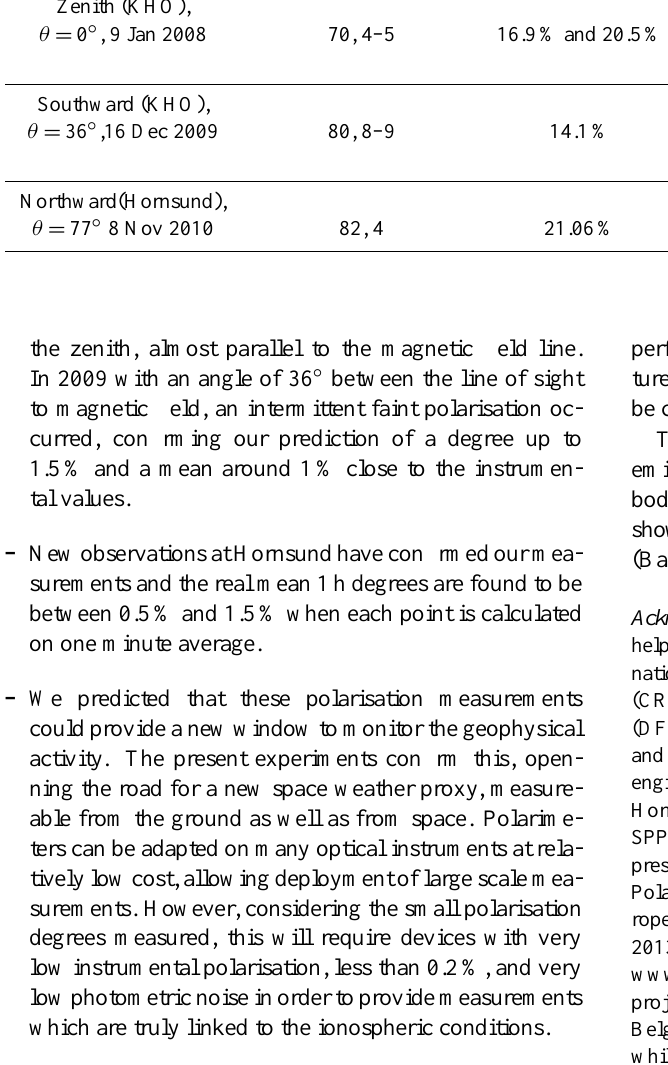
Table 1. Summary of the SPP results. The polarisation data are presented as raw data without taking into account the instrumental polarisation and the light pollution. Observation Geophysical conditions P 0 . 4 − 0 . 6 polarisation degree (raw) polarisation direction (raw) Angle ( θ ) between the line-of-sight and B f 10 . 7 , A p Northward (KHO), θ = 85 ◦ , 11 Dec 2007 87, 8–9 33.9% P = 2–4% 20 ◦ Zenith (KHO), θ = 0 ◦ , 9 Jan 2008 70, 4–5 16.9% and 20.5% P = 1% ∼ 0 ◦ Southward (KHO), θ = 36 ◦ ,16 Dec 2009 80, 8–9 14.1% P = 1% ∼ 0 ◦ Northward(Hornsund), θ = 77 ◦ 8 Nov 2010 82, 4 21.06% P = 1 . 36% ∼ 0